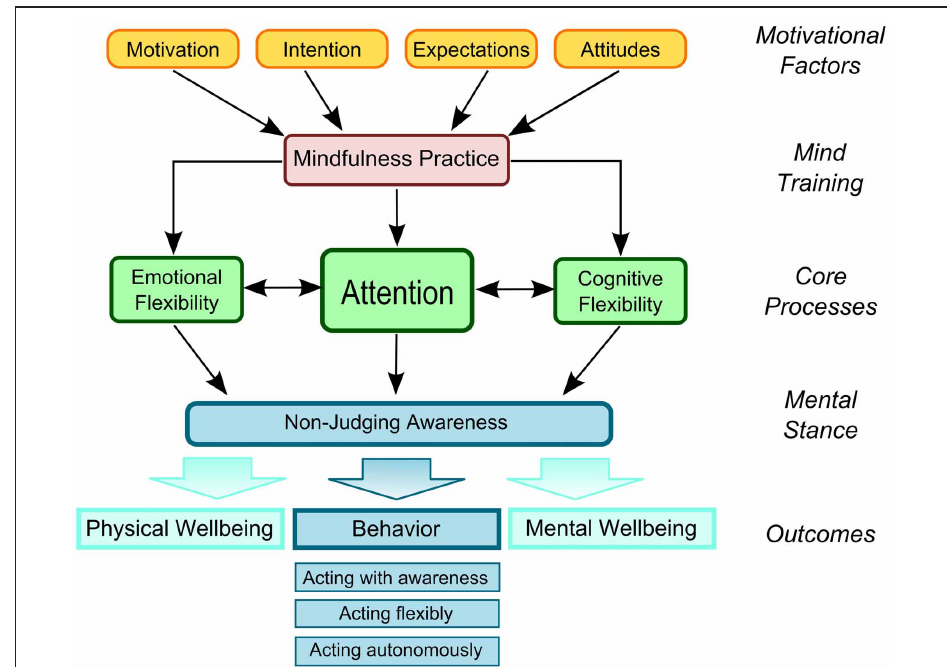
FIGURE 1 | The Liverpool Mindfulness